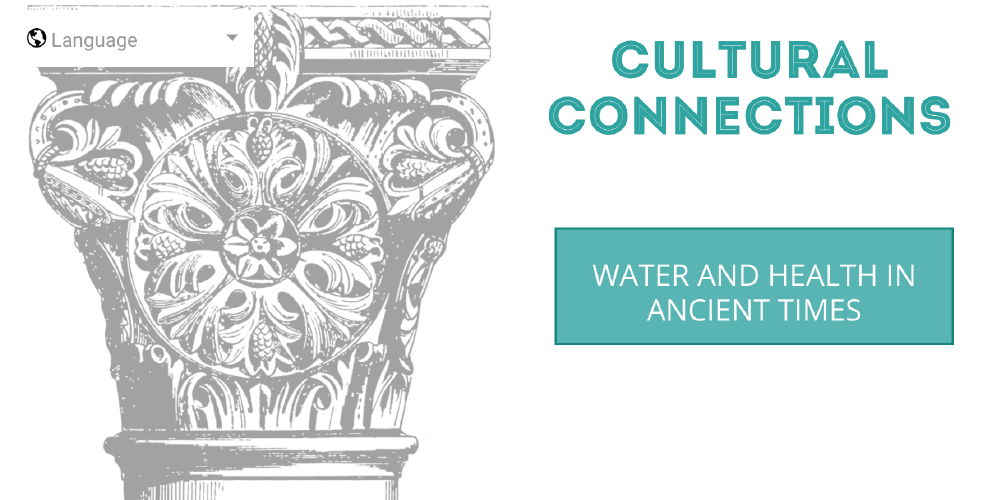
Figure 2. Listing the experiences available in a